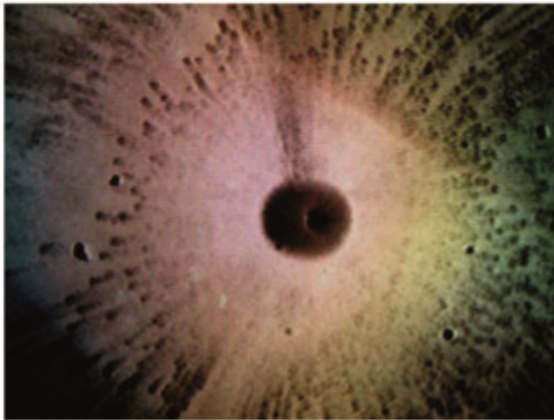
Figure 4. A photo of the microstreaming generated by a 10 μm EMB located at an antinode of a standing wave of 160 kHz ultrasound. Reproduced with permission from [10].